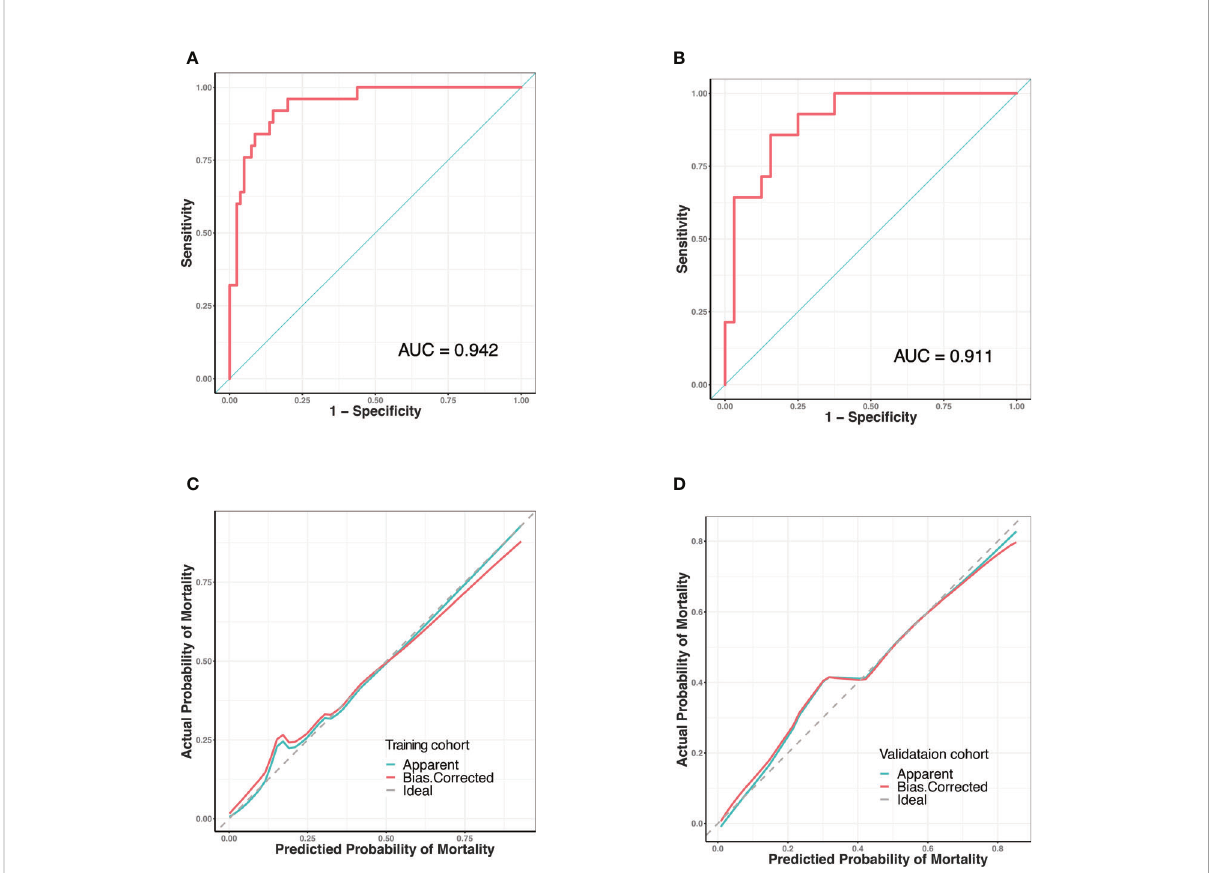
FIGURE 3 Receiver operating characteristic (ROC) curves and predictive performance of the nomogram for predicting mortality risk in SAP patients with GNB infection. (A) ROC curve for the predictive model of the training cohort. Area under the curve was 0.942. (B) ROC curve for the predictive model of the validation cohort. Area under the curve was 0.911. (C) Validity of the predictive performance of the nomogram in estimating the risk of mortality in the training cohort. (D) Validity of the predictive performance of the nomogram in estimating the risk of mortality in the validation cohort. ROC, receiver operating